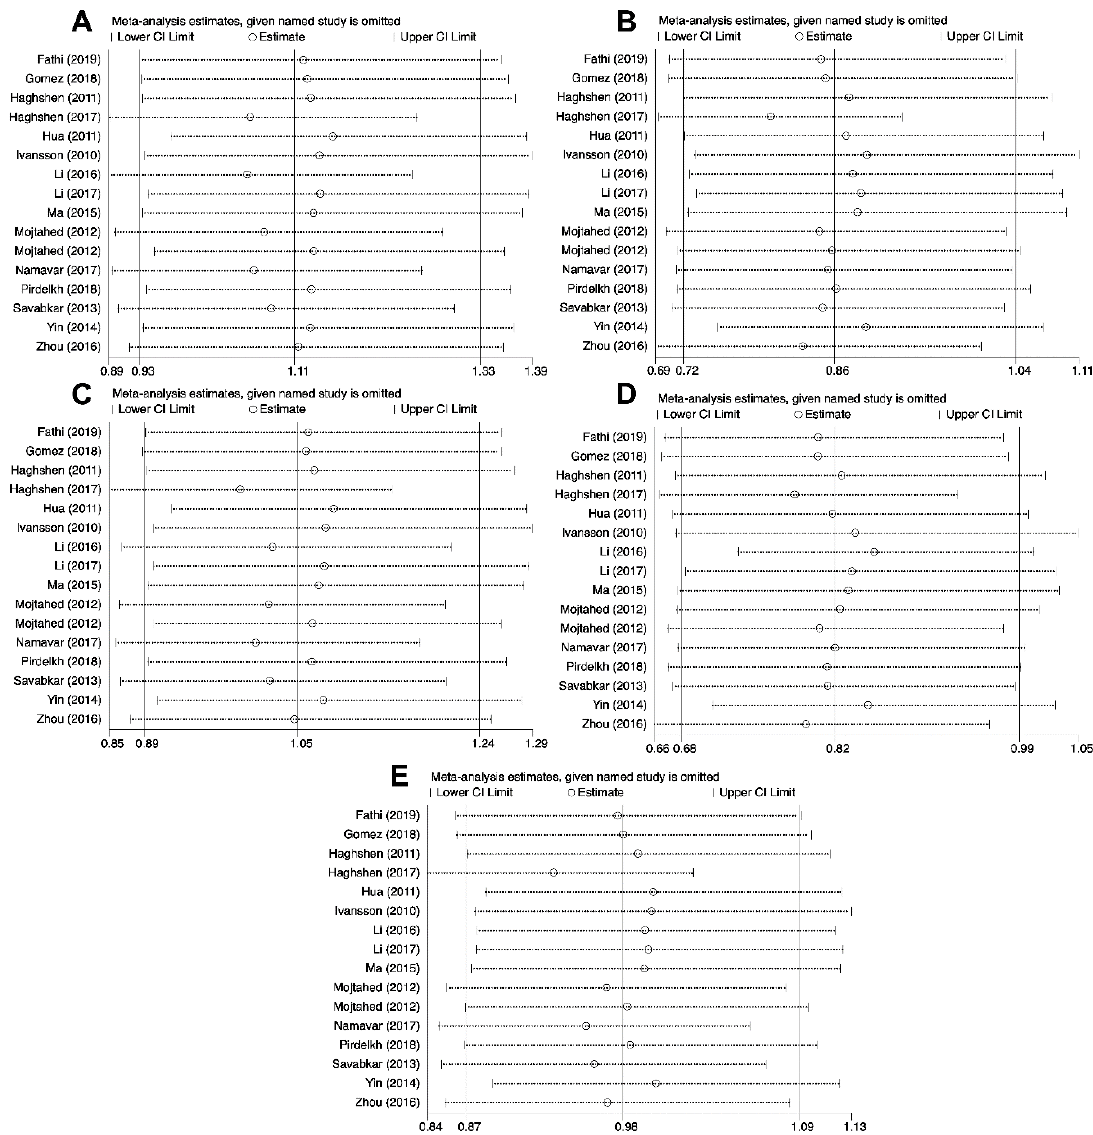
Figure 6. Sensitivity analyses for studies on PD-1 rs2227981 polymorphism and cancer susceptibility for CG vs. GG ( A ), CC vs. GG ( B ), CG + CC vs. GG ( C ), CC vs. CG + GG ( D ), and C vs. G ( E ).